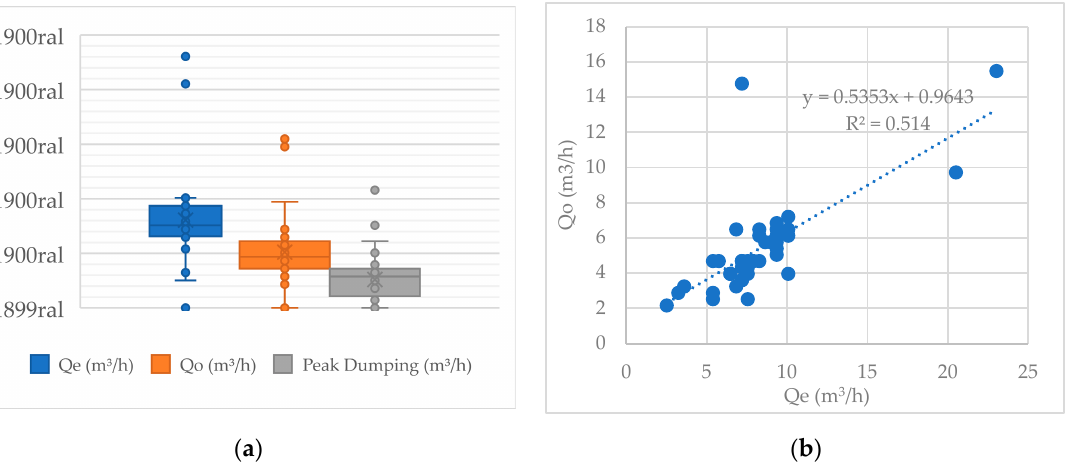
Figure 6. Swale inflow/outflow ( a ) volumes and peak dumping distribution, ( b ) inflow and out- flow volumes regression.